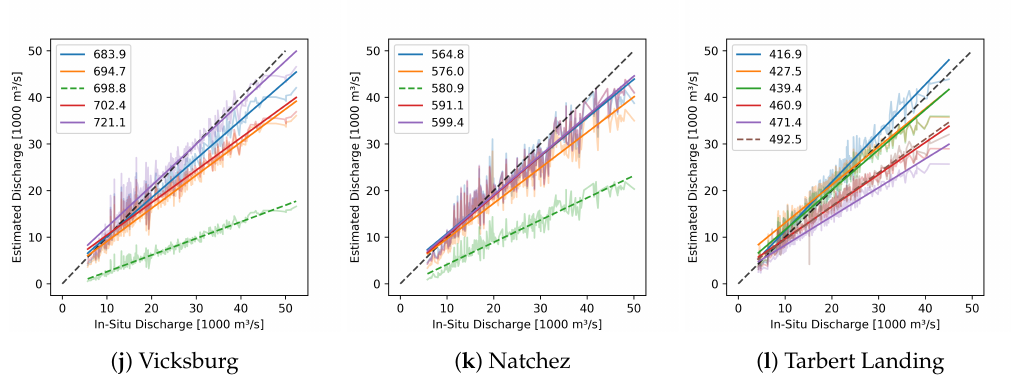
Figure 14. In-Situ vs. estimated discharge and linear regression for each CS using all estimated parameters ( a – c ), bathymetric survey data ( d – f ), bathymetric survey data and variable in situ flow gradients ( g – i ), and variable in situ flow gradient and estimated bathymetry ( j – l ). The black dashed lines show the optimum relation. The colored dashed lines represent the CS at the gauges.